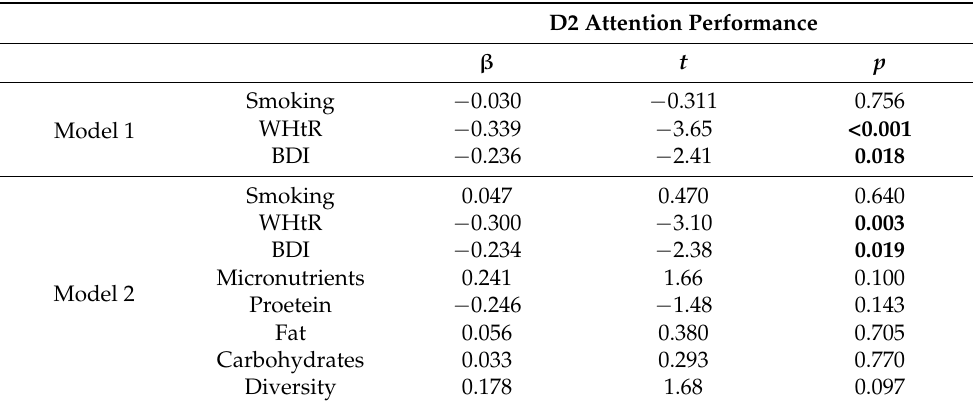
Table 6. Association of nutritional behavior with d2 attention